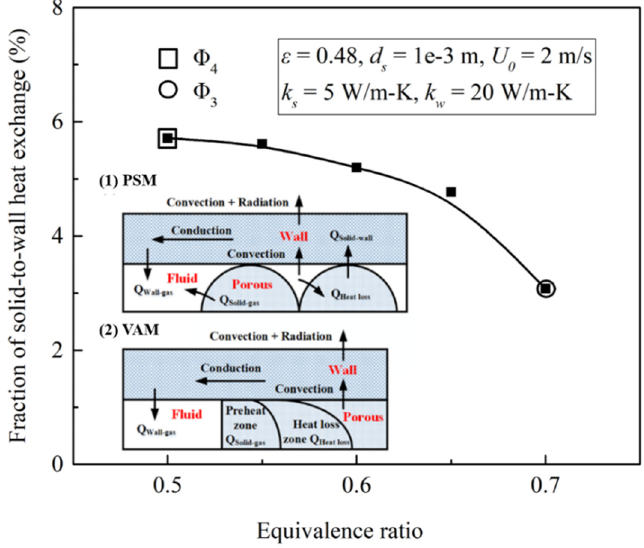
Figure 7. Fraction of solid-to-wall heat exchange ( η s − w ) obtained by the PSM.